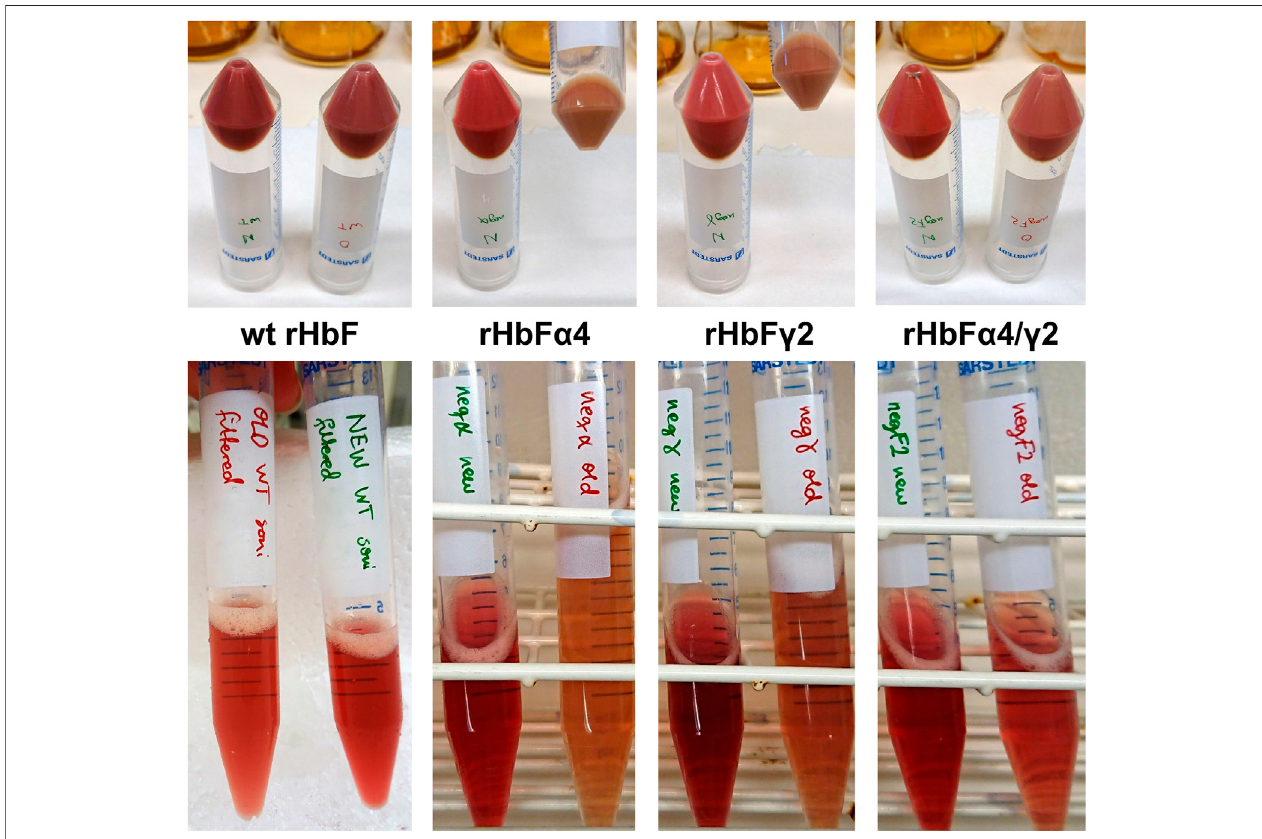
FIGURE 2 | Photos of cell pellets and crude extracts of the HbF variants wt rHbF, rHbF α 4, rHbF γ 2, and rHbF α 4/ γ 2, cultivated in parallel either with a previously established shake fl ask protocol (OD 600 0.1 at induction, 30 ° C, 150 rpm, 0.3 mM ALA, and 0.1 mM IPTG) or the improved protocol (OD 600 4 at induction, 35 ° C, 140 rpm, 0.7 mM ALA, and 0.3 mM IPTG). The cultures grown with the improved protocol had higher Hb-CO concentrations in the crude extracts, as also can be seen by the more intense red color in those